Question: Write a single sentence explaining what this figure depicts.
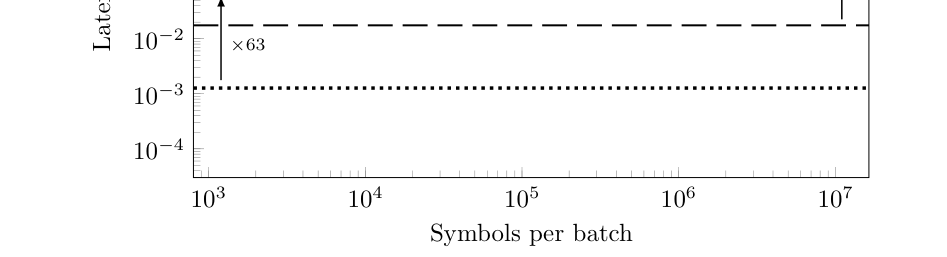
Answer: Comparison of the latency of the CNN-based equalizer, running on GPU, CPU and FPGA. PT refers to the PyTorch and TRT refers to the TensorRT models.